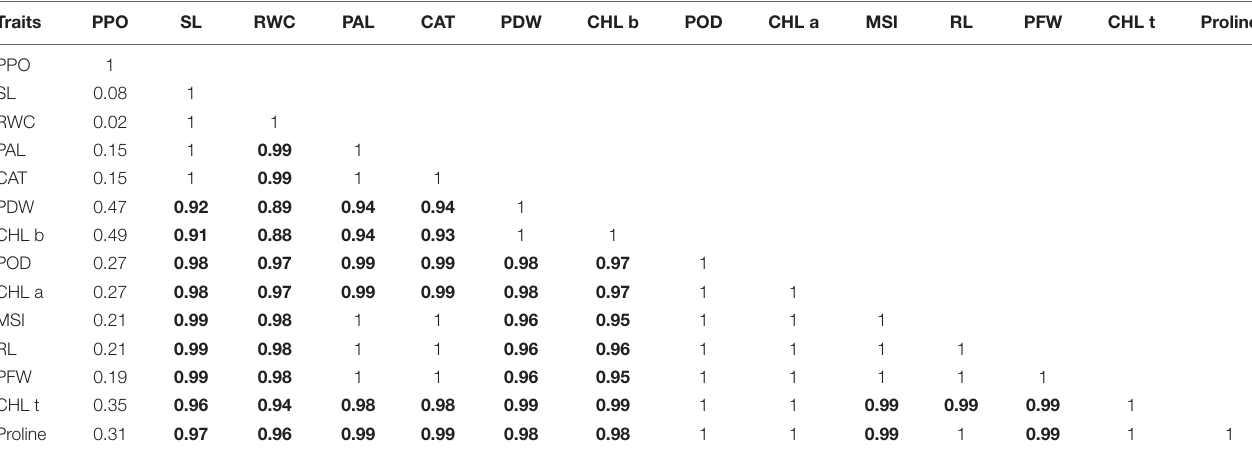
MSI 0.21 PFW 0.19 0.99 0.98 1 0.96 0.95 CHL t 0.35 0.96 0.94 0.98 0.98 0.99 0.99 1 0.99 0.99 0.99 1 Proline 0.31 0.97 0.96 0.99 0.99 0.98 0.98 1 1 0.99 1 0.99 1 1